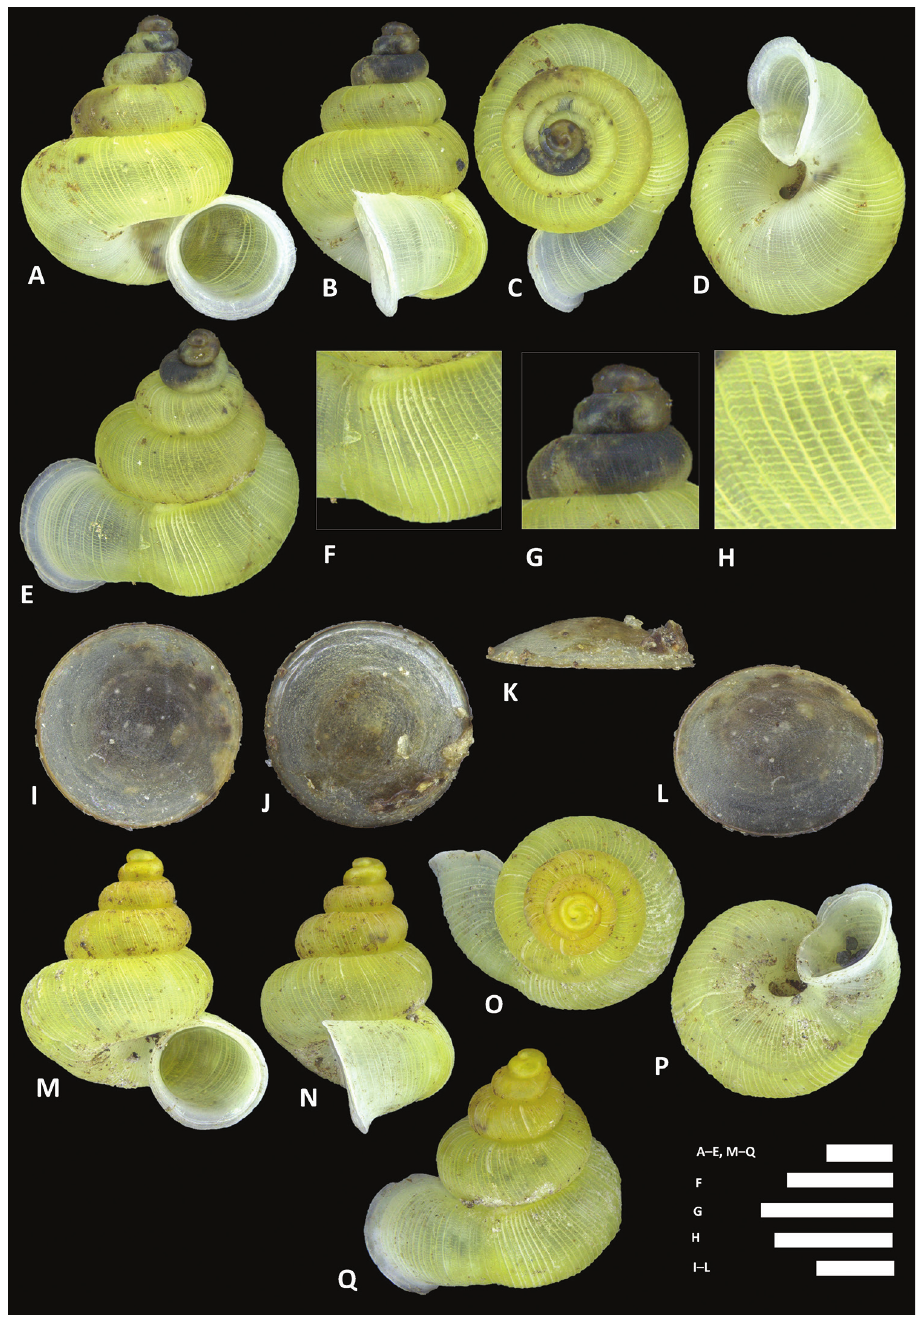
Figure 18. Alycaeus ikanensis sp. n. A–E Shell of holotype, BOR/MOL 12972 F–H Close up of shell of holotype, BOR/MOL 12972 I–L Operculum of holotype, BOR/MOL 12972 M–Q Shell of paratype, BOR/MOL 6834. Scale bars: A–H, M–Q 1 mm; I–L 0.5 mm. All photographs by Junn Kitt